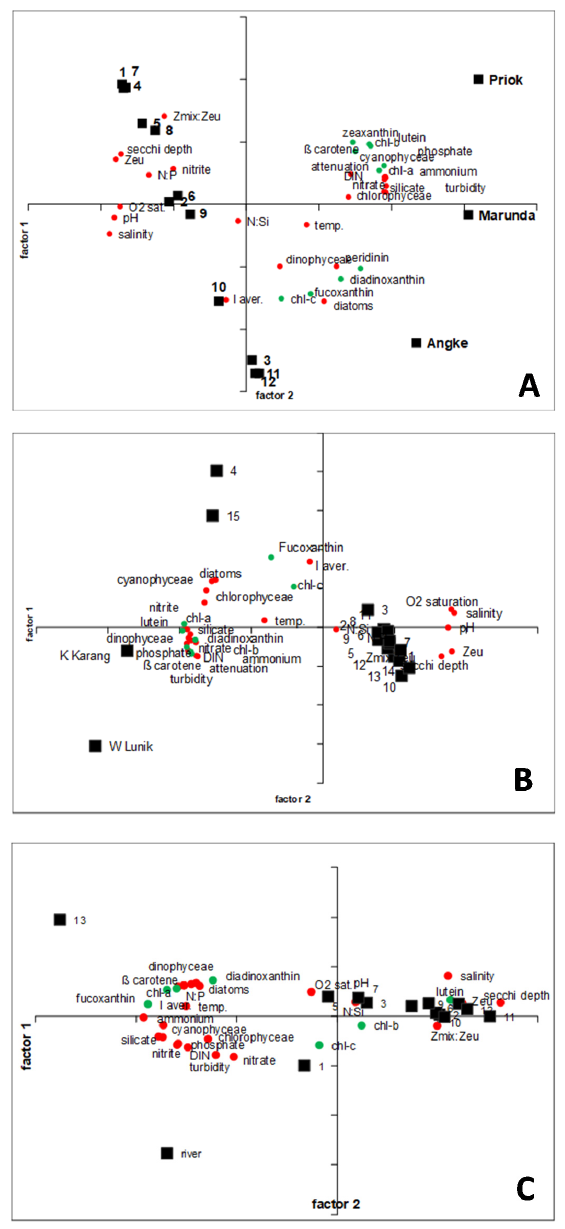
Figure 7. Multivariate analysis (principal component analysis (PCA) biplot) between phytoplankton pigments, phytoplankton groups, nutrient species, physical-chemical properties of water, and station numbers in Jakarta Bay (upper graph ( A )), Lampung Bay (middle graph ( B )), and Semangka Bay (lower graph ( C )). Black boxes indicate measurement stations, green circles indicate algae pigments, and red circles indicate chemical and physical properties of water.